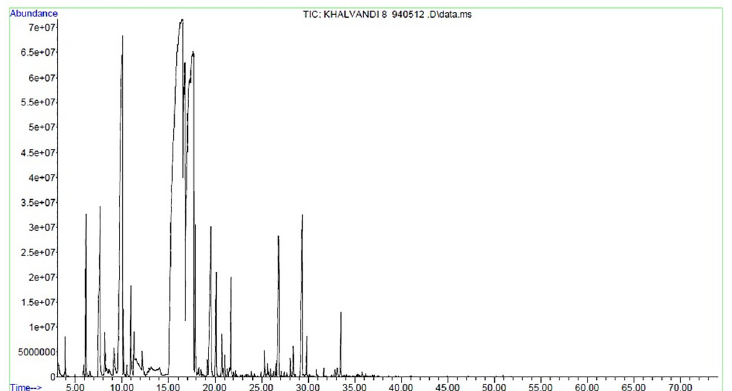
Fig 1. Mentha piperita essential oil